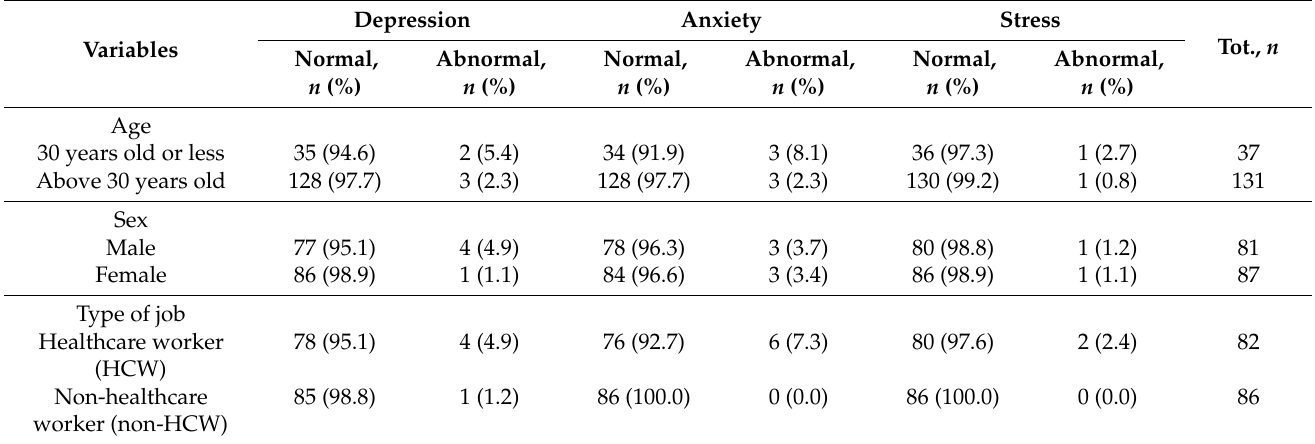
Table 3. By age, by sex, and by type-of-job prevalence of psychological